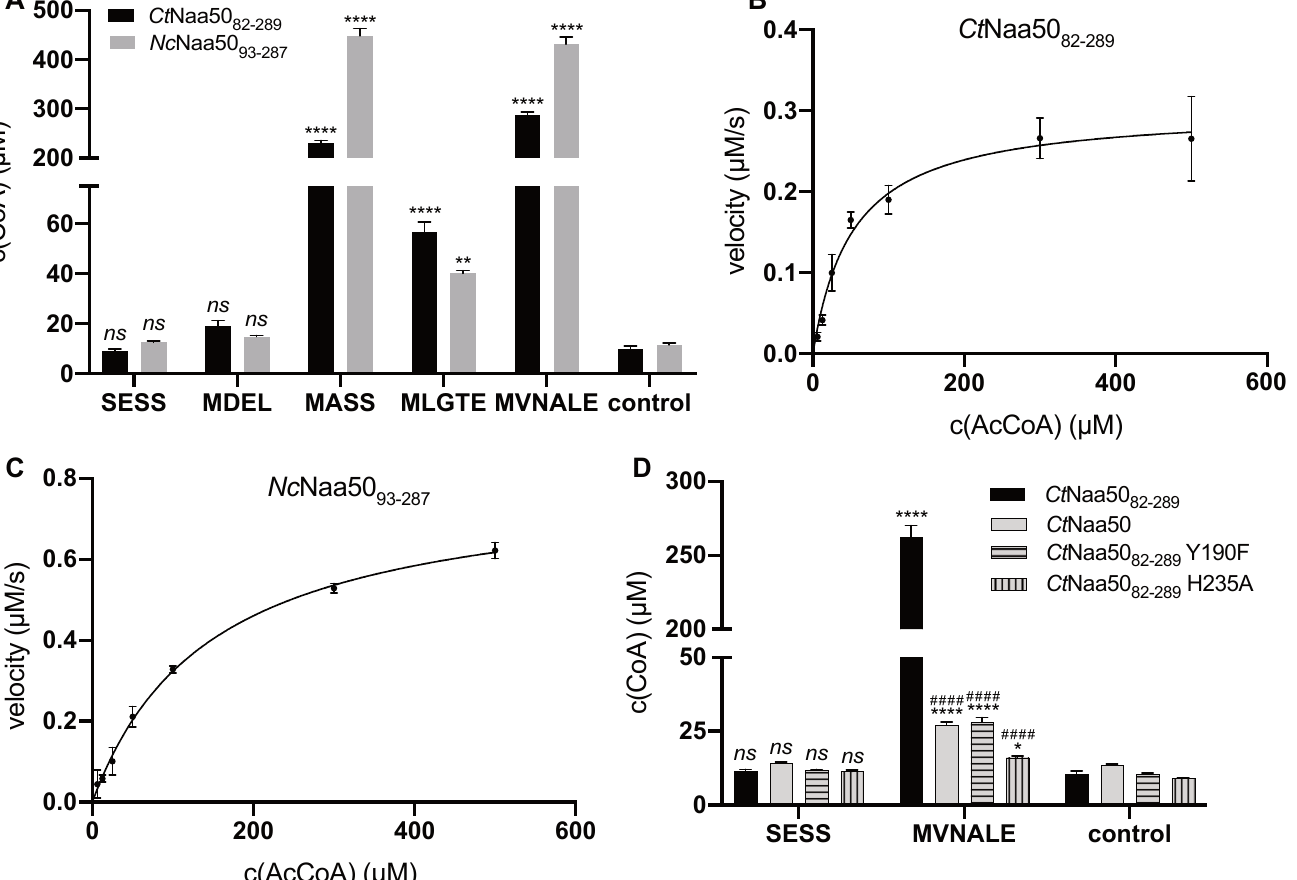
Figure 3. Ct Naa50 82-289 and Nc Naa50 93-287 acetylate canonical NatC/E/F substrates. ( A ) Both GNAT constructs, Ct Naa50 82-289 and Nc Naa50 93-287 , showed the highest acetylation activity towards MVNALE and MASS peptides, followed by MLGTE and insignificant activity for MDEL. SESS was not acetylated. Control reactions were performed without peptides. Acetylation by both enzymes of different peptides was compared against the peptide-free controls with a one-way ANOVA statistical analysis with Dunnett’s correction ( ns = not significant, ** = p -value ≤ 0.0021, **** = p -value ≤ 0.0001). ( B ) Michaelis– Menten kinetics of MVNALE acetylation by Ct Naa50 82-289 . ( C ) Michaelis–Menten kinetics of MVNALE acetylation by Nc Naa50 93-287 . ( D ) Ct Naa50 82-289 Y190F and H235A mutants showed reduced MVNALE acetylation. Full-length Ct Naa50 also showed reduced activity. Acetylation of SESS or MVNALE by Ct Naa50 variants was compared against the peptide-free controls with a one-way ANOVA with Dunnett’s correction ( ns = not significant, * = p -value ≤ 0.0332, **** = p -value ≤ 0.0001). Acetylation of MVNALE by Ct Naa50 variants was compared against Ct Naa50 82-289 with a one-way ANOVA with Dunnett’s correction ( #### = p -value ≤ 0.0001). All measurements were performed in triplicates and are presented as means ±